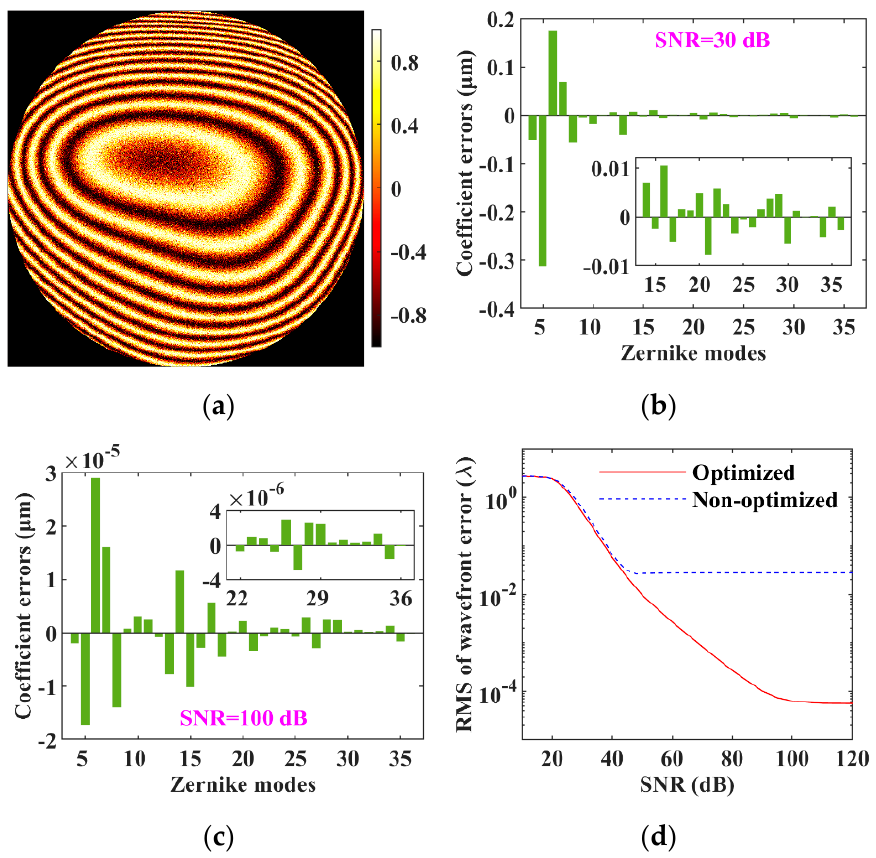
Figure 7. Anti-noise performance of vSHWS with and without parameter optimizations. ( a ) Real part of E generated by using a preset wavefront with a SNR of 30 dB; Zernike coefficient errors obtained by the optimized vSHWS at SNRs of ( b ) 30 dB and ( c ) 100 dB; ( d ) performance of the optimized and non-optimized vSHWS at different SNRs.